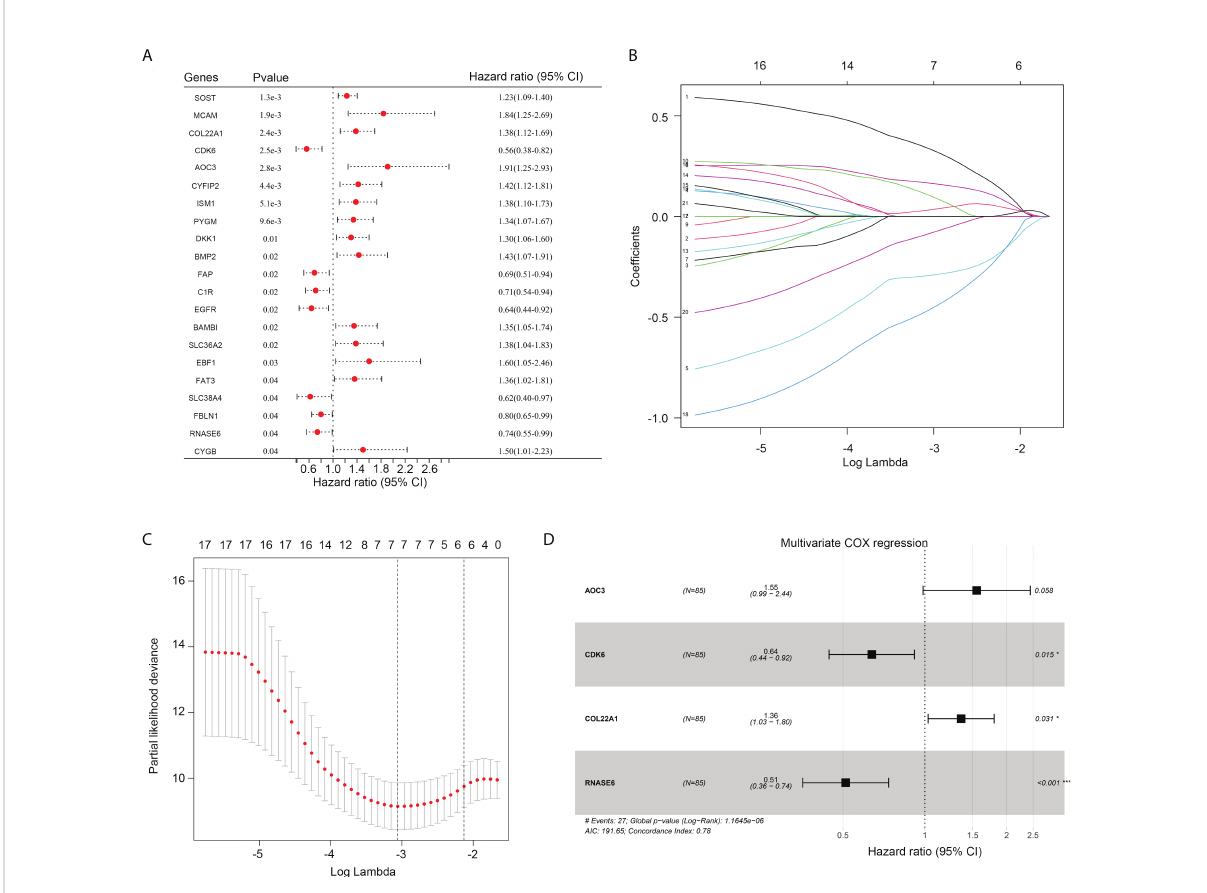
FIGURE 3 Construction of a risk model. (A) Univariate COX regression analysis for the 94 genes associated with the in fi ltration of resting dendritic cells. (B, C) LASSO analysis for other important genes associated with the survival rate of OS. (D) The HR and p value of genes (including AOC3, CDK6, COL22A1 and RNASE6) under multivariate COX analysis are